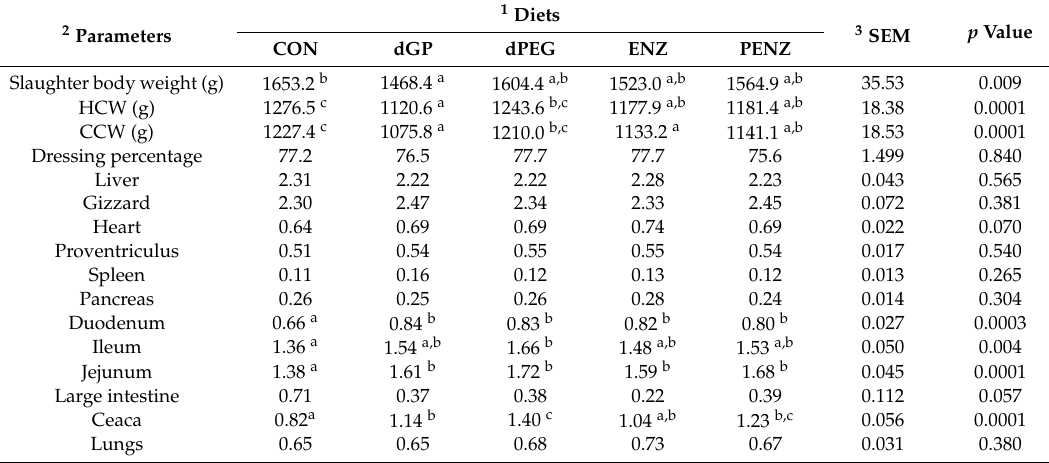
Table 6. E ff ect of treating dietary red grape pomace with polyethylene glycol and a cellulolytic enzyme mixture on internal organs and carcass characteristics (g / 100 g HCW, unless otherwise stated) of broiler chickens.